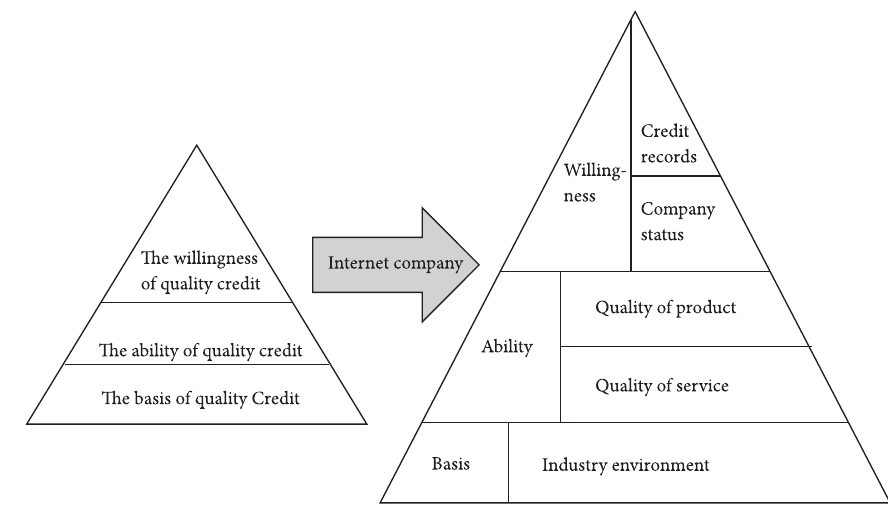
Figure 2. Quality credit evaluation